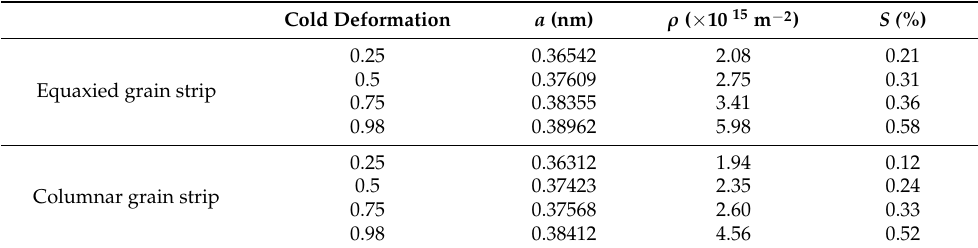
Table 1. Lattice parameters a, dislocation density ρ , and microstrain S of cold rolled alloys.